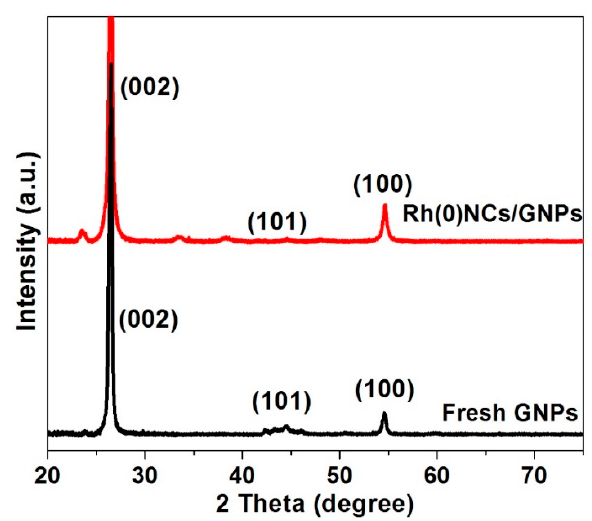
Figure 5. X-ray diffraction (XRD) patterns of fresh GNPs and Rh(0)NCs/GNPs.